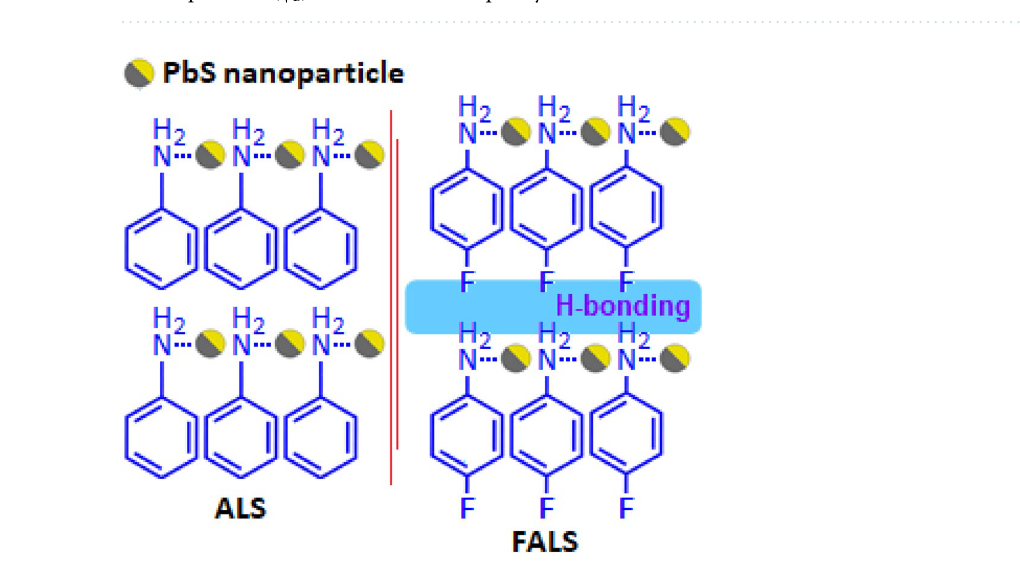
Figure 5. ( A ) Dielectric constant (ε ′ ) of FALS based device measured at 30, 60, 80, 100 and 120 °C under the frequency range from 100 Hz to 1 MHz. The variation of tan δ curves for selected temperatures, inset. ( B ) Graphical representation of capacitance as a function of frequency under applied voltage conditions. ( C ) 1/C 2 –V plot under selected frequency conditions. ( D ) and ( C ) represent the variation of carrier concentration (N D ) and barrier potential (ϕ B ) as a function of frequency, for FALS based